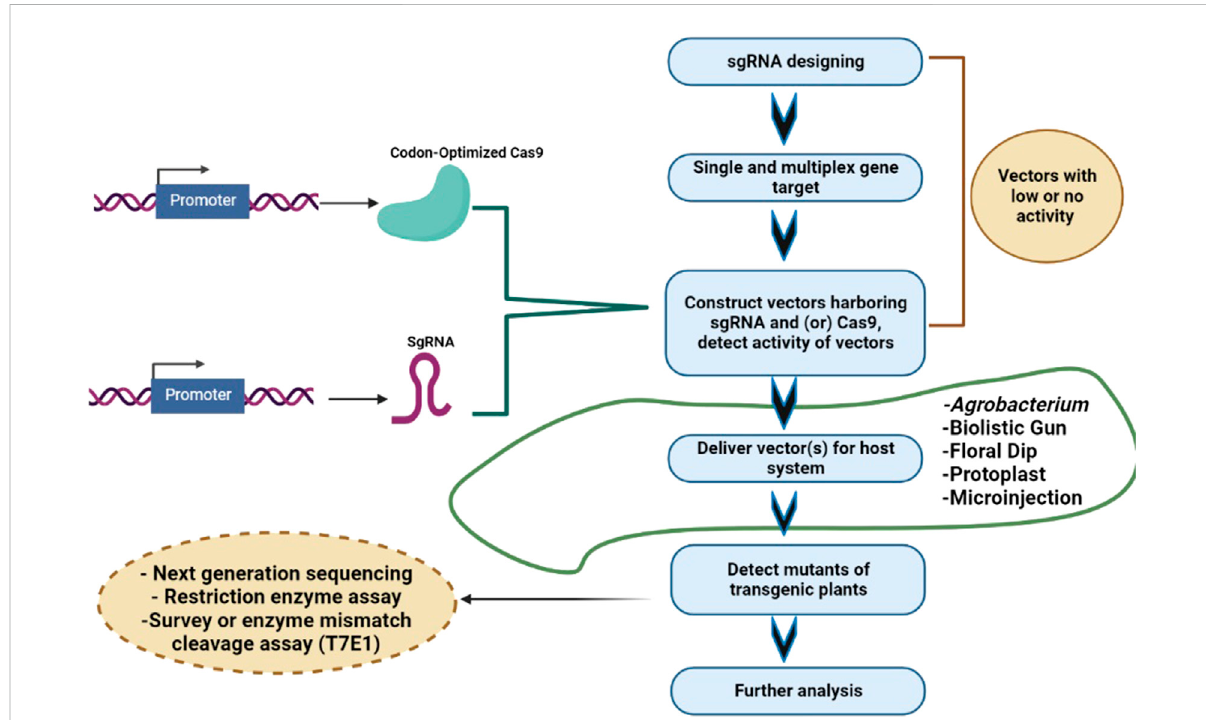
FIGURE 1 StepsinvolvedinCRISPR/Cas9-basedgeneeditingofcereals.SelectionoftargetgeneandgRNAdesign;cloningofCas9andgRNAinasuitable vector; vector delivery into the plants via Agrobacterium tumefaciens or particle bombardment, and screening of mutant/edited cereal crops using Sanger